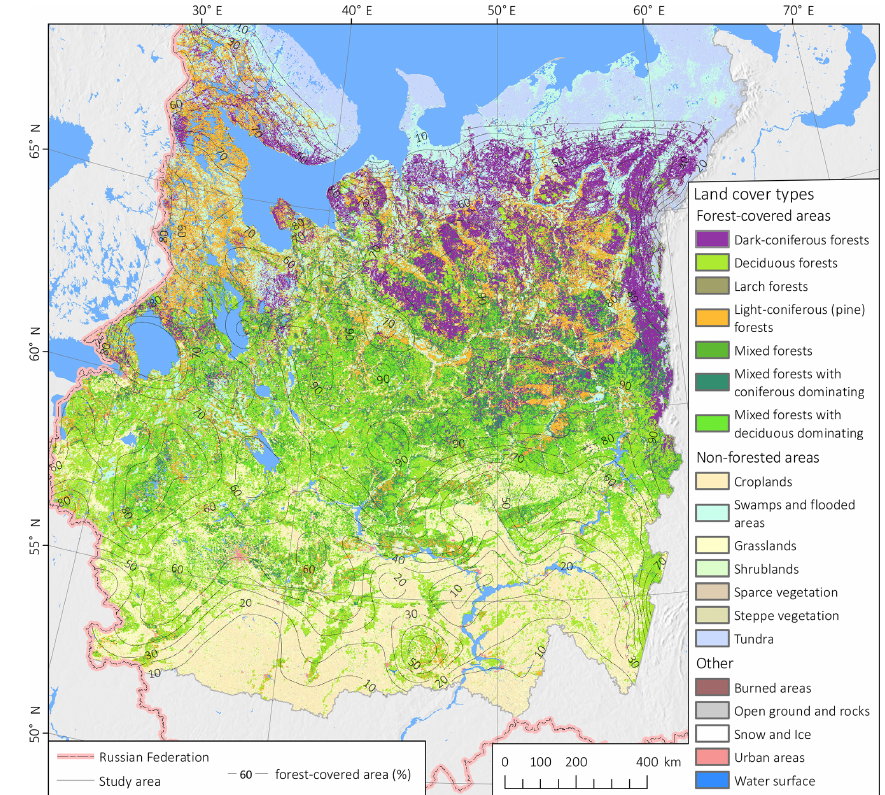
Figure 1. Land cover types within the study area according to the map of vegetation cover of Russia developed by the Space Research Institute of the Russian Academy of Sciences (Bartalev et al.,